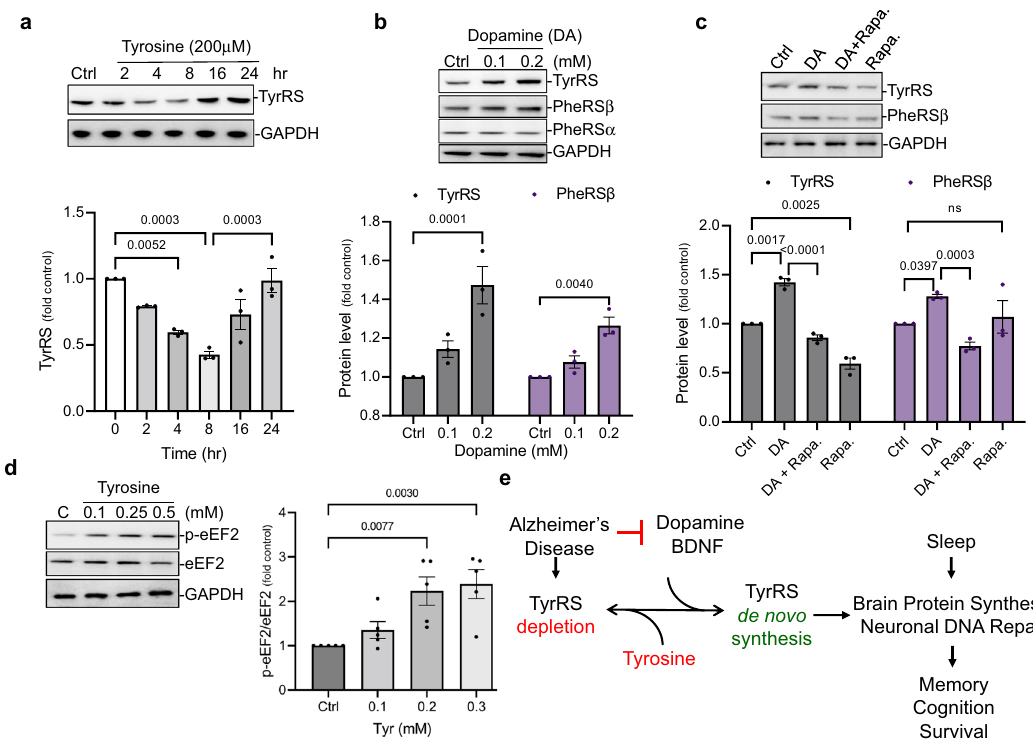
Fig. 2 Dopamine activates the de novo synthesis of neuronal TyrRS. a L-Tyrosine effect on TyrRS protein levels is reversible . Rat cortical neurons were treated with L-tyrosine (200 μ M) for up to 24 hr, and TyrRS was detected by WB analysis using anti-TyrRS antibody. b Dopamine (DA) increases neuronal TyrRS levels . Representative immunoblots for TyrRS and PheRS α / β after treatment with DA (100 – 200 μ M) for 30 min in rat cortical neurons (DIV 9). c Rapamycin prevents DA-induced increase in TyrRS levels . Representative immunoblots for TyrRS and PheRS β after 30 min treatment with either DA (100 μ M) alone or in combination with rapamycin (100 nM) in rat cortical neurons (DIV 9). d Tyrosine induces the phosphorylation of eEF2 . Primary cortical neurons were treated with L-tyrosine (100 – 300 μ M) for 8 hr and p-eEF2 was detected by WB analysis using anti-p-eEF2 antibody ( n = 5). e Schematic representation of the potential mechanism of regulation of the neuronal protein levels of TyrRS . All data represent mean ± SEM for n = 3 experiments with signi fi cance measured using two-way ANOVA with Tukey ’ s test for multiple comparisons. Source data are provided as a Source Data fi